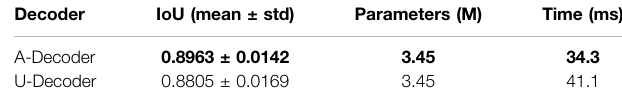
TABLE 2 | The results of ablation study for RepVGG-A1.